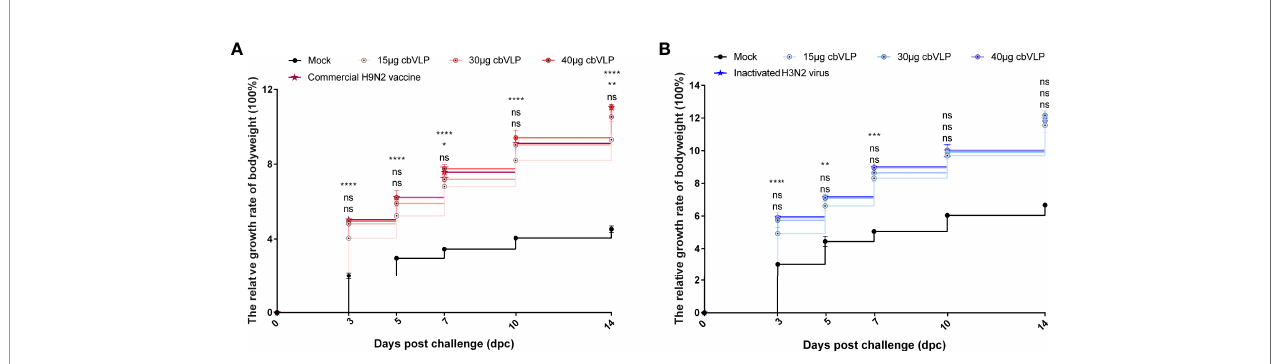
FIGURE 6 | The changes of bodyweights of those immunized chickens after challenge with H9N2 or H3N2 AIV strains. Panel (A) : H9N2 challenge; Panel (B) : H3N2 challenge. Signi fi cance of difference was compared between cbVLPs and commercial H9N2 vaccine or inactivated H3N2 vaccine by a Two-Way ANOVA test. There was no signi fi cant difference in growth rate between the 40 m g cbVLP group and the vaccine groups. Statistical differences were indicated by asterisk (ns P > 0.05, *P < 0.05, **P < 0.01, ***P < 0.001, ****P < 0.0001).